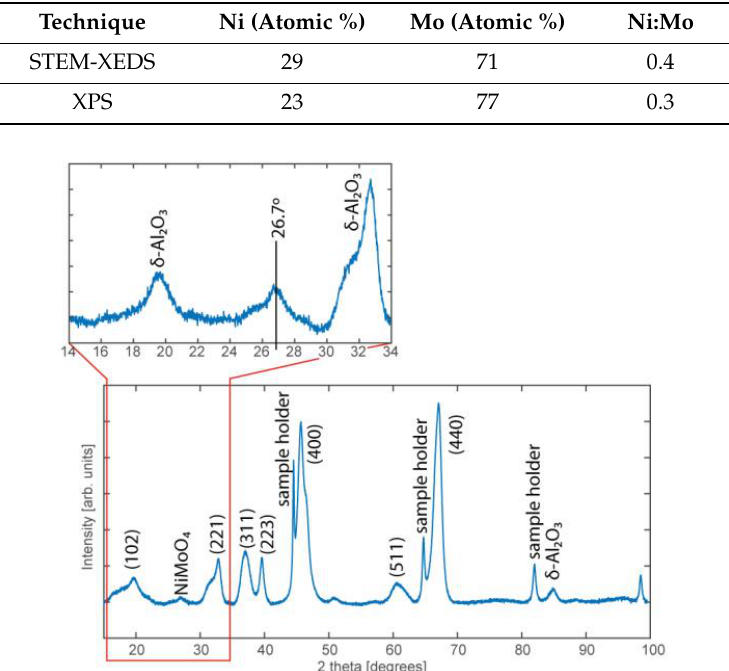
Table 2. Average atomic percentage of Ni and Mo in the industrial NiMo/δ-Al 2 O 3 catalyst measured at 26 different positions on the support using STEM-XEDS, and the Ni and Mo composition determined by XPS. Figure 4. STEM HAADF and XEDS mapping of the industrial NiMo/δ-Al 2 O 3 catalyst. ( a ) STEM HAADF image at one edge of the catalyst. The blue squares indicate the region in which elemental analysis was performed. The scale is the same for all images. Strong Al ( b ) and O signals ( c ) were observed in the XEDS mapping image, originating largely from the alumina support. The much weaker signals from Mo ( d ) and Ni ( e ) are due to the low concentrations of these metals in the catalyst, but XEDS mapping indicates that the catalytically active Ni and Mo are well-dispersed over the support. The loading of Ni and Mo is estimated to be submonolayer on the δ -Al 2 O 3 surface, based on the measured wt % of the Ni and Mo and the surface area of the support.